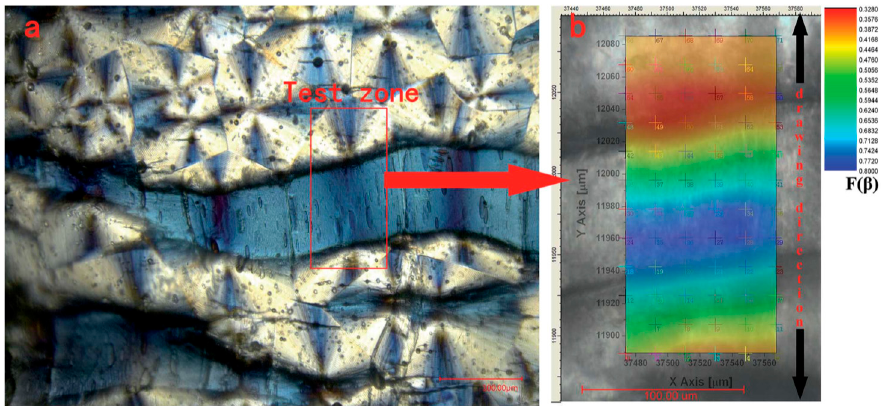
Figure 3. ( a ) Primary polymorphs of PVDF ( α , β , γ ). ( b ) Electric field-induced phase transitions of PVDF. The transverse dipole moment of each polymer chain is shown using an orange arrow that points from the negatively charged fluorine atoms to the positively charged hydrogen atoms. T-trans; G-gauche [28].